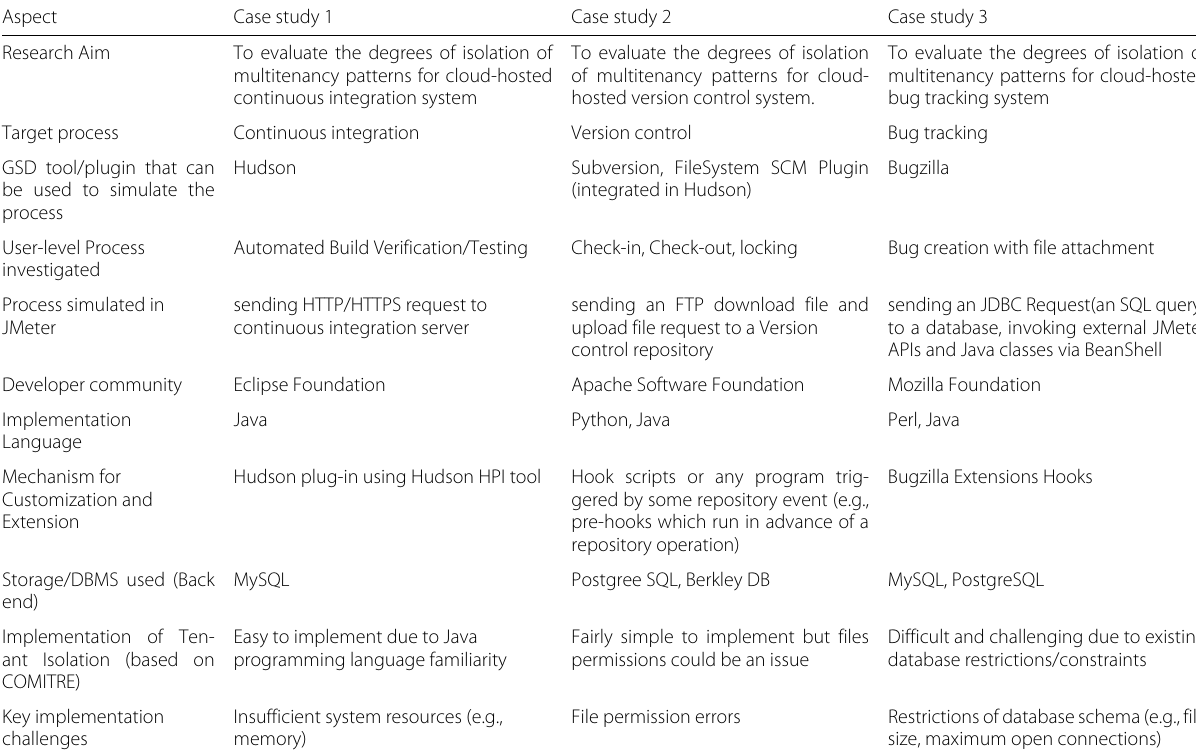
Table 6 Characteristics of the Case Studies